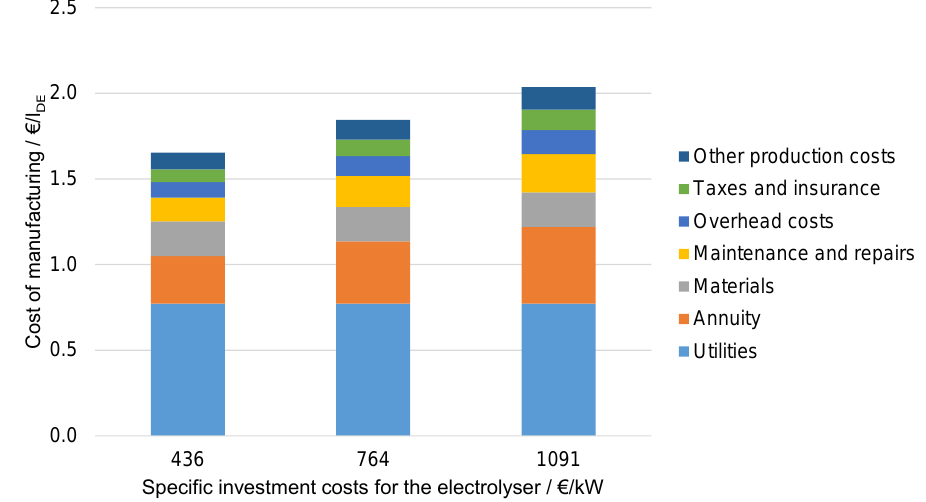
Figure 18. Product production costs as a function of electrolyzer investment costs.